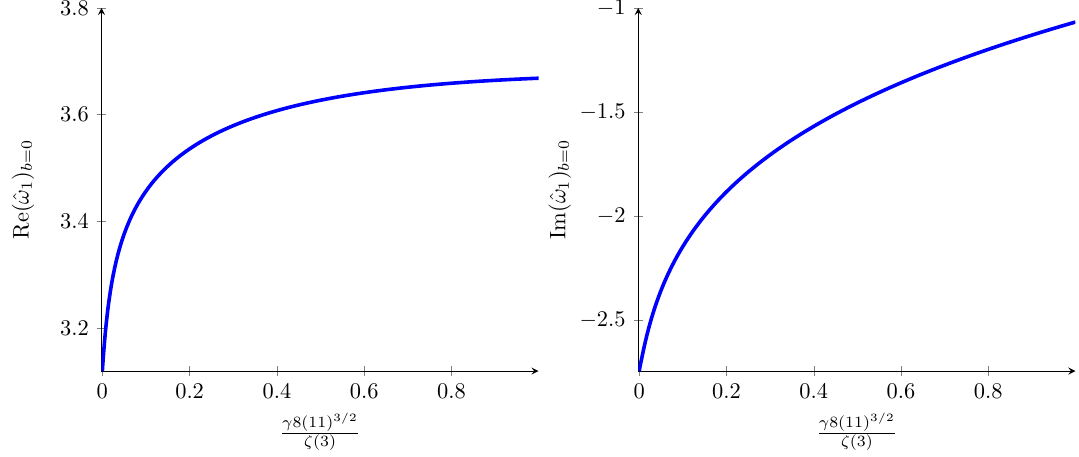
Figure 8 . The coupling corrected and resummed imaginary and real part of the lowest QNM with b = 0 and q = 0 on the same (cid:13) -interval as the plots shown in (cid:12)gure 7. As in the (cid:21) limit [2] the magnetic background (cid:12)eld decreases both the real part of the QNM frequencies and 1 the equilibration time (cid:28) Im( ! 1 ) / (cid:0)